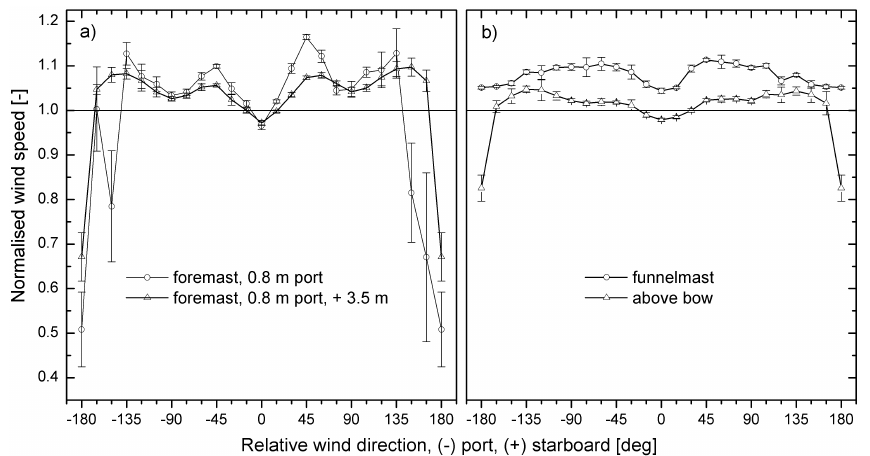
Fig. 2. R/V Hakuho Maru : normalised wind speed (as fraction of the undisturbed speed) against relative wind direction at various anemome- ter locations (see Fig. 1, top panel): [1] foremast (17ma.s.l.), [2] foremast +3.5m (20.5ma.s.l.), [3] funnelmast (30.5ma.s.l.), and [4] above bow (23ma.s.l.). Error bars indicate standard deviation. A bow-on wind is represented by a relative wind direction of 0 ◦ .